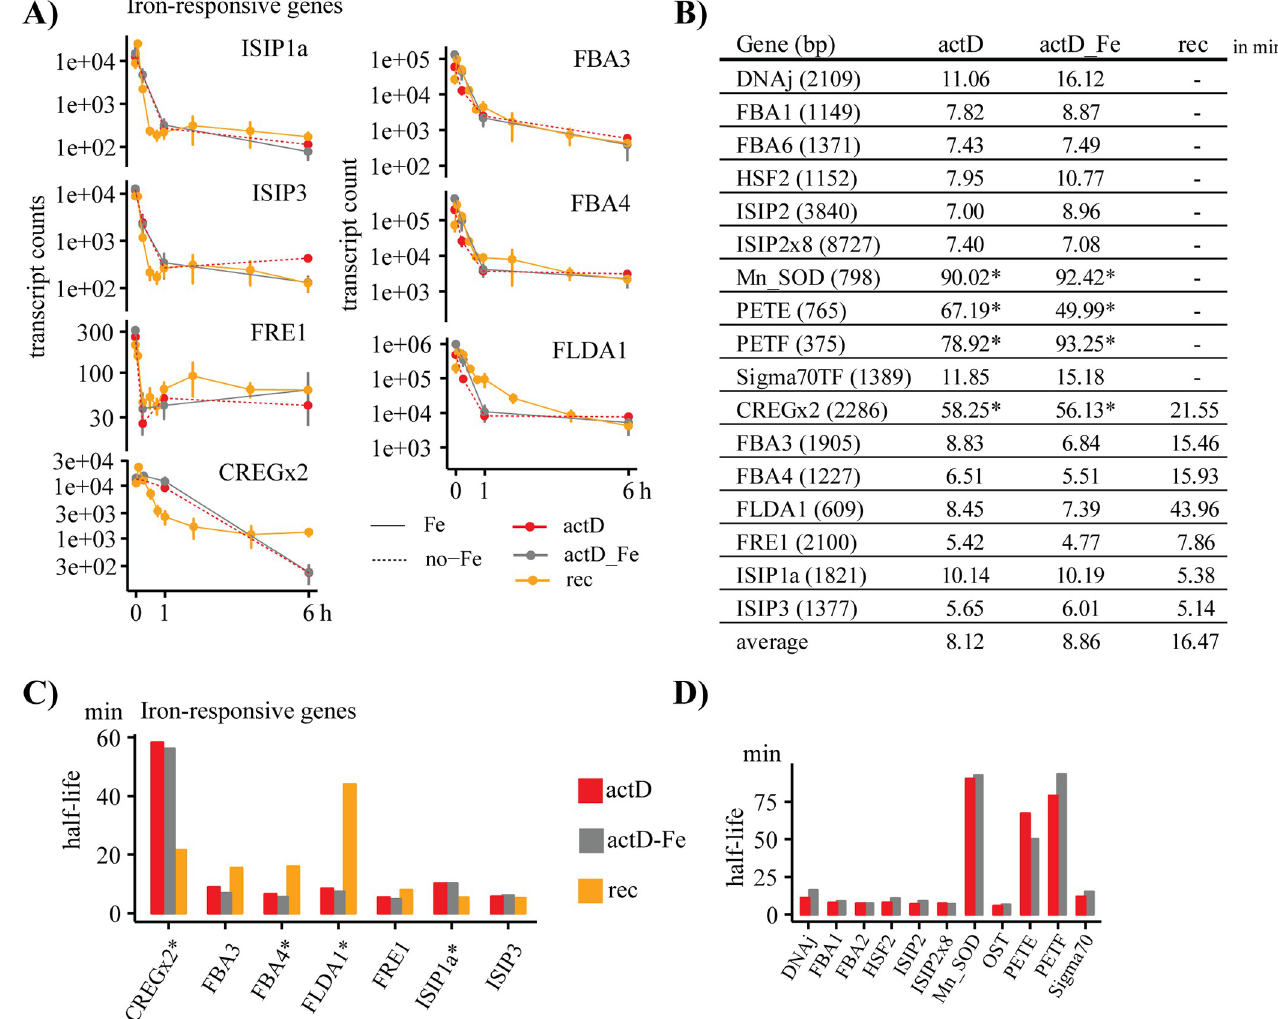
PLOS ONE | https://doi.org/10.1371/journal.pone.0280827 January 24,